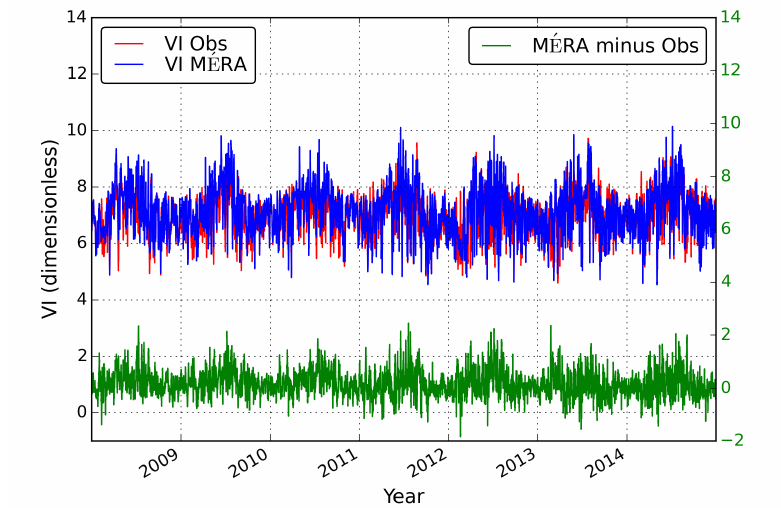
Figure 13. Time series of daily variability index averaged over all Irish TUCSON stations. Thirty-day averaging is applied. Observations, MÉRA data and the bias in MÉRA relative to observations are shown. Data for the period 2008 to 2014 are